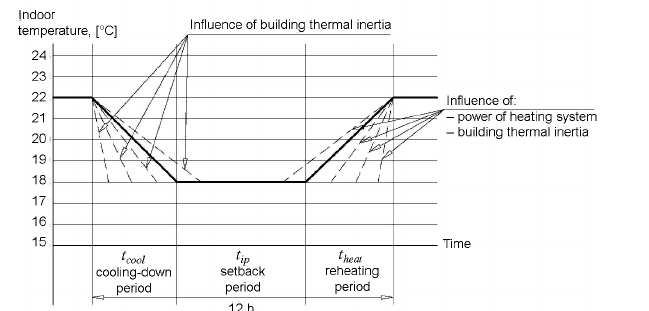
Fig. 8. Phases of intermitted heating, during the 48 h of weekend temperature reduced period